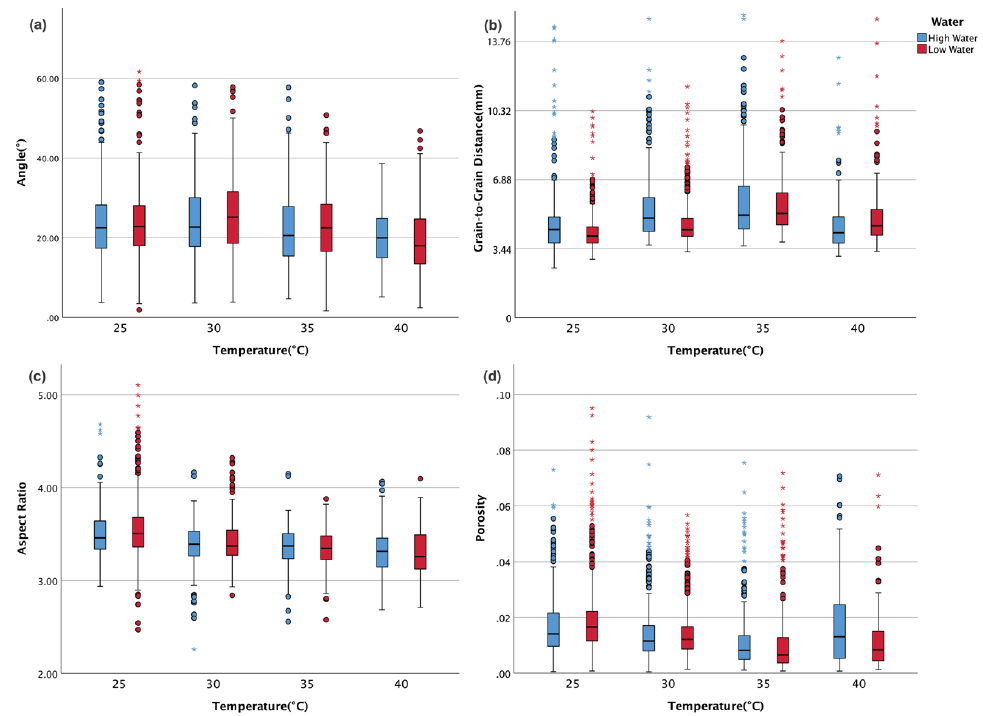
ff erent temperature and water